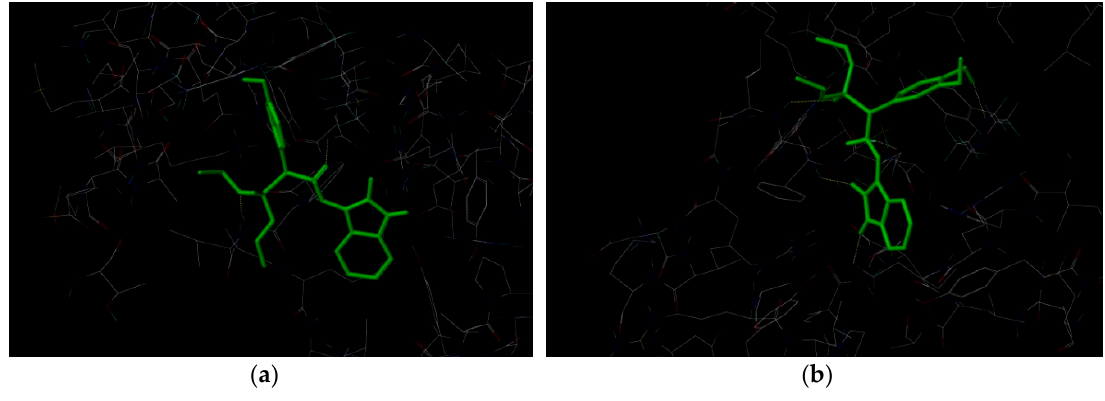
Figure 3 . 3D representation of binding modes and molecular interactions of methylphosphonate derivatives ( a ): 4f and ( b ): 4g .